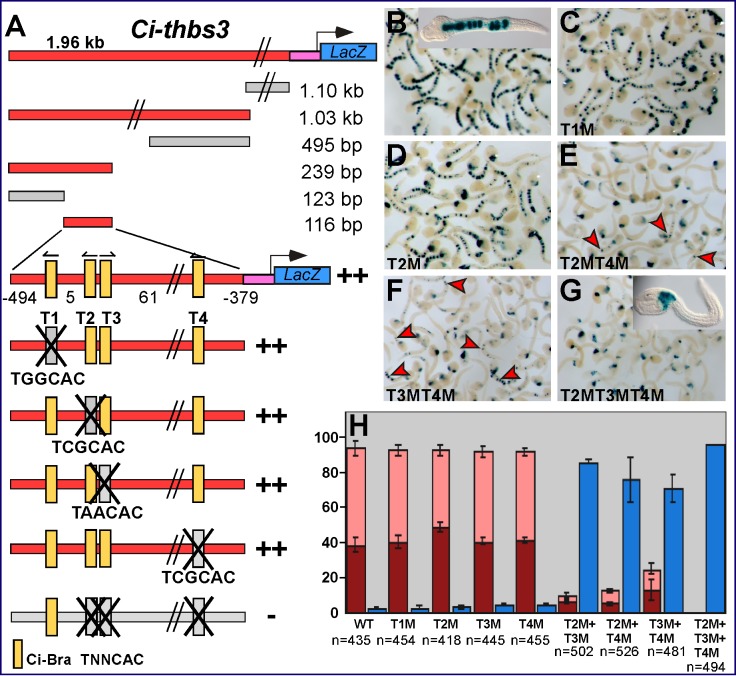
Synergistic activity of three Ci-Bra binding sites in the Ci-thrombospondin 3 notochord CRM.Identification of the minimal sequences necessary for notochord activity of the Ci-thbs3 notochord CRM through sequence-unbiased truncations and site-directed mutations. Red and grey rectangles symbolize genomic fragments displaying or lacking notochord activity, respectively. A pink rectangle indicates the Ci-FoxA-a basal promoter and a blue rectangle the LacZ reporter, both present in the electroporation vector (not drawn to scale; omitted in the truncation and mutation constructs for clarity). Parallel diagonal lines indicate genomic regions that are present in the constructs but are not depicted in the figure. “+” and “−” signs are used to show presence or absence of notochord activity, respectively. Putative binding sites are indicated by the symbols in the figure; their orientation is provided by small arrows on top of each site. Mutagenized sequences are depicted in grey and marked by an “X”. (A) Sequence-unbiased truncations and site-directed mutations. Putative Ci-Bra binding sites are indicated as T1–T4. (B–G) Low-magnification group microphotographs of late tailbud embryos electroporated in parallel with either the wild-type 116-bp Ci-thbs3 notochord CRM (B) or with mutated versions of this construct carrying either individual (C,D), double (E,F), or triple (G) mutations in the Ci-Bra binding sites. The mutations were as follows (mutated sequences are in lower case): T1M, TGGCAC to TGGtct; T2M, TCGCAC to TCGtct; T3M, TAACAC to TAAtct; T4M, TCGCAC to TCGtct. Insets in (B,G) show higher magnification views of representative stained embryos. (H) Quantification of the activity of the constructs shown in (B–G) in different tissues, as detected by X-Gal staining. The y-axis reports the percentage of embryos showing staining in a certain tissue as a fraction of the total number of stained embryos scored. Dark red, activity in notochord only; pink, activity in notochord and in additional tissues; blue, activity only in tissues other than notochord. The number of stained embryos scored (n) for each construct is shown below the x-axis. Results were averaged from three independent experiments carried out on different batches of embryos.